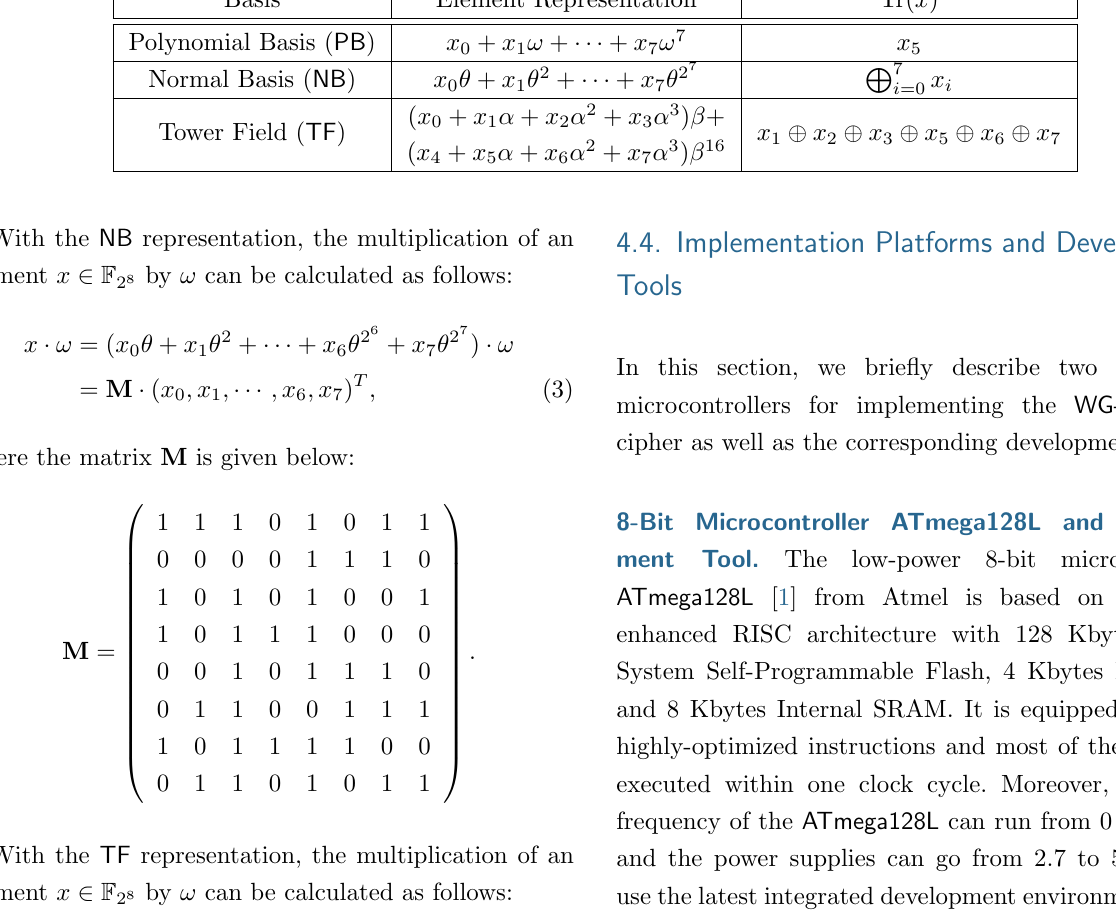
Table 2. Trace Computation of an Element x